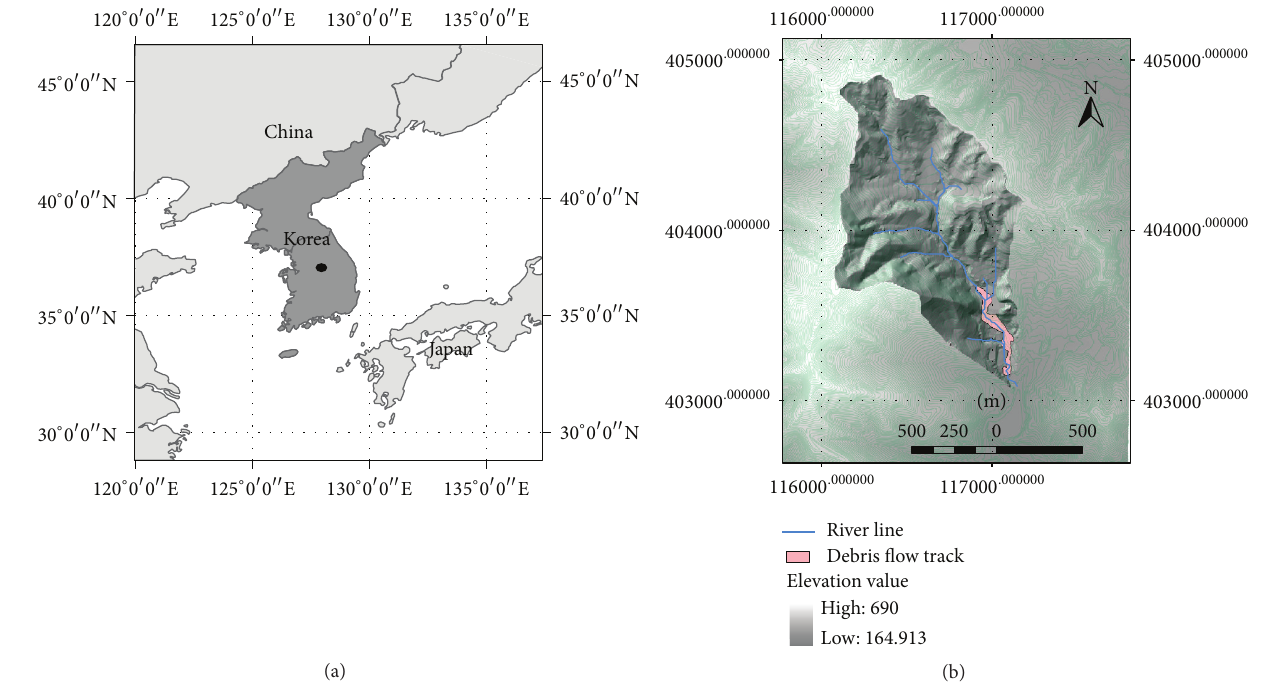
Figure 1: The location of study area (a) and debris flow occurring in basin